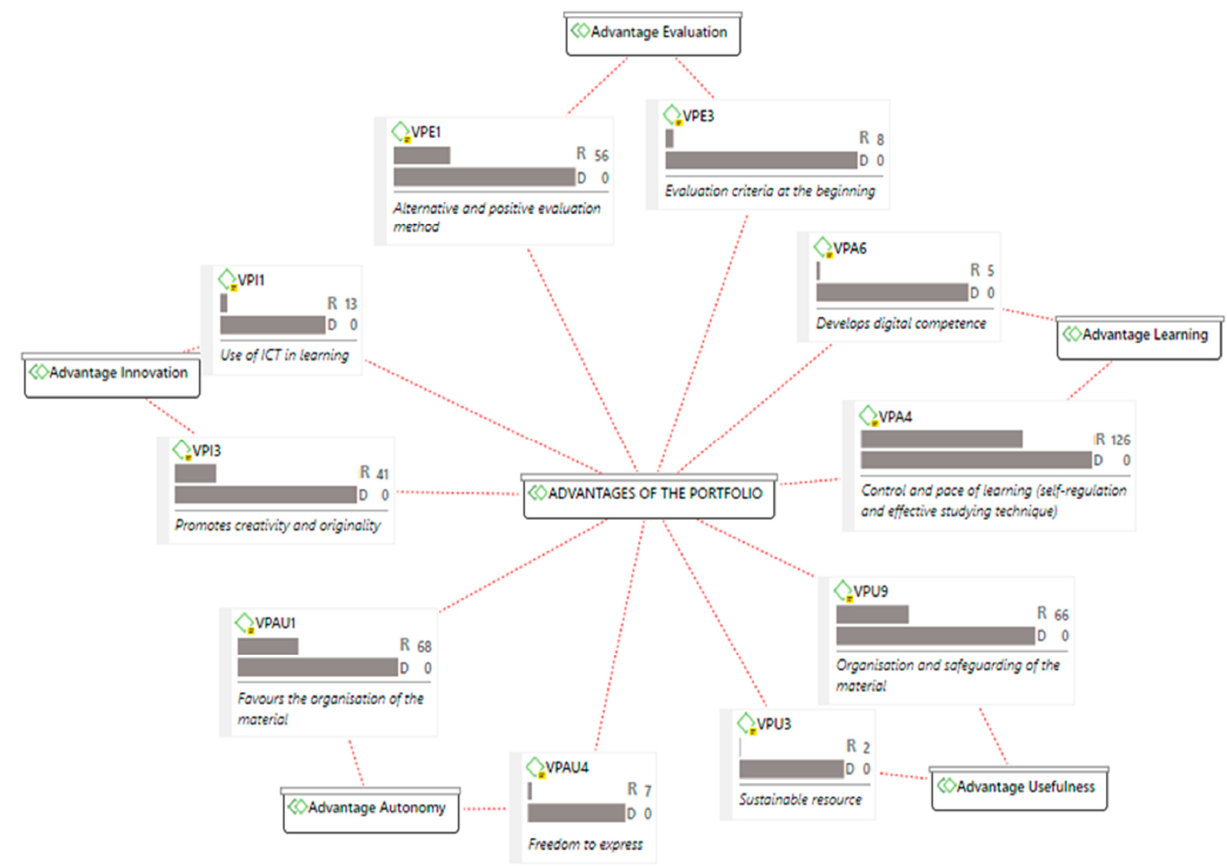
Figure 1. Map of maximum and minimum advantages by category/code (R: rooting; D: density).